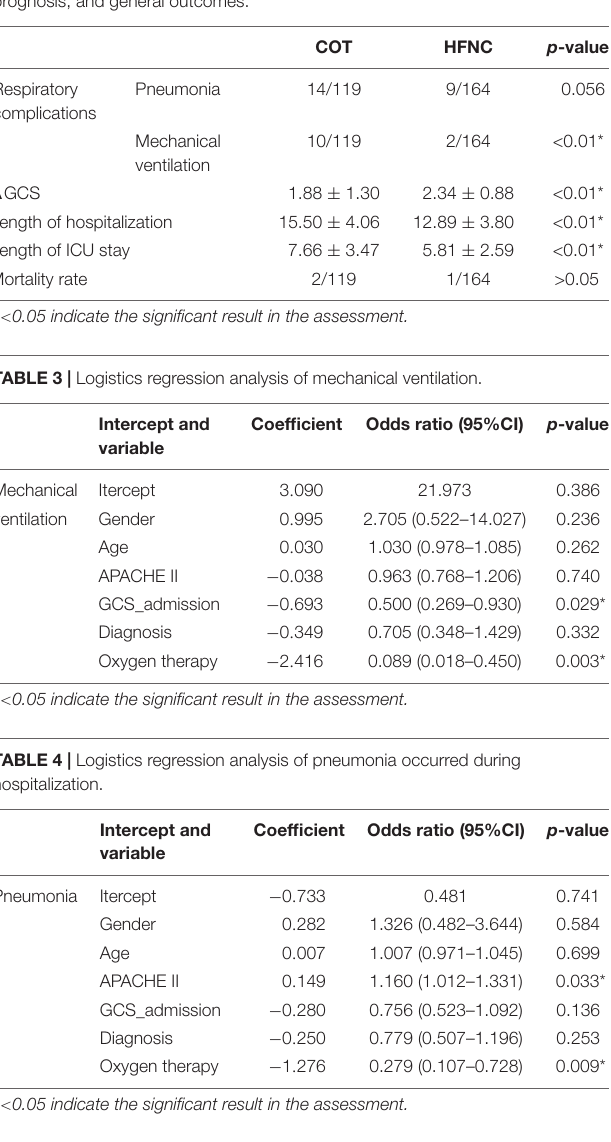
TABLE 6 | Linear regression analysis on (cid:49) GCS.